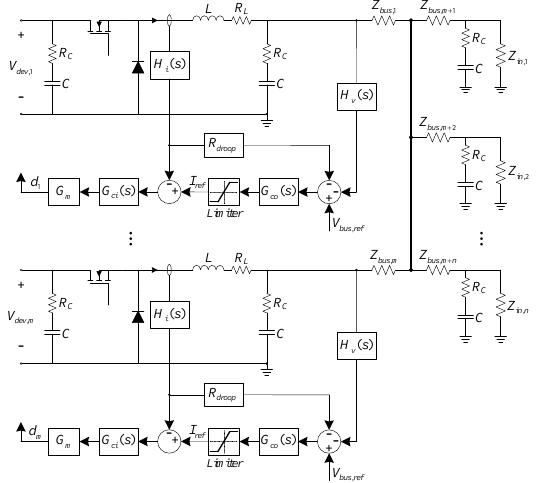
Figure 10. The control block diagram of bus-regulating